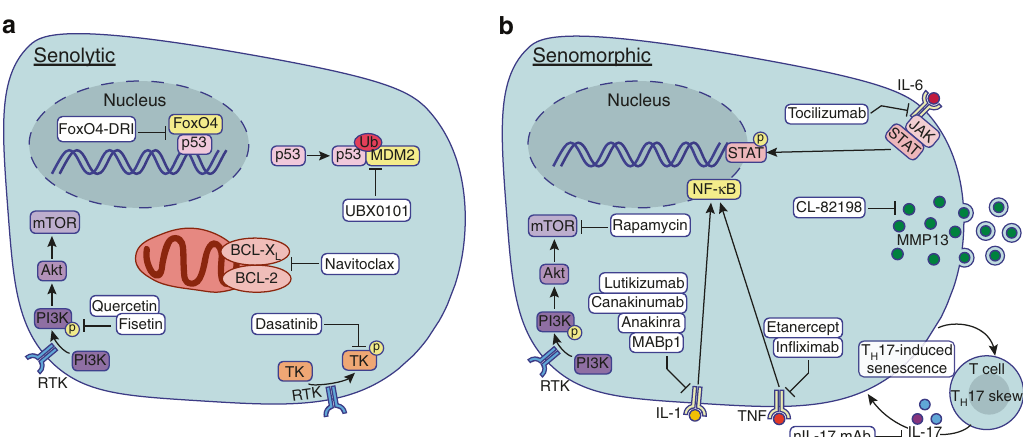
Fig. 4 Senolytic and senomorphic therapeutic strategies. a Senolytic strategies seek to preferentially induce apoptosis in senescent cells and target molecules or signaling pathways that are increased in senescent cells such as p53, BCL-X L and BCL-2, and survival signaling through receptor tyrosine kinases (RTKs). b Senomorphic strategies target SASP factors that can cause further in fl ammatory paracrine signaling and tissue damage. CL82198, a selective MMP13 inhibitor, and rapamycin, an mTOR inhibitor, are both senomorphics under assessment. Blocking antibodies as well as neutralizing antibodies for several SASP factors (IL-1, IL-6, TNF) are being tested for ef fi cacy against further tissue damage. Neutralizing IL-17a/f monoclonal antibodies (nIL-17 mAb) are under evaluation to disrupt the feedforward cycle of T H 17 skewing